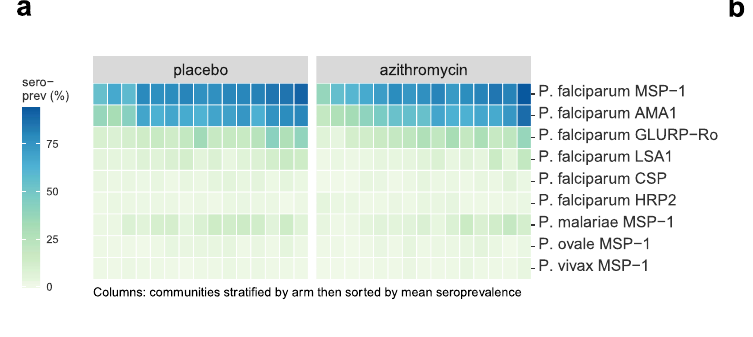
humans, but in vitro and in vivo animal studies have shown azithromycin had comparable antimicrobial activity against G. duodenalis to metronizadole (the fi rst-line treatment) 23 and small scale (uncontrolled) human studies suggest cure rates in excess of 90% 24 . Azithromycin has modest activity against P. falciparum